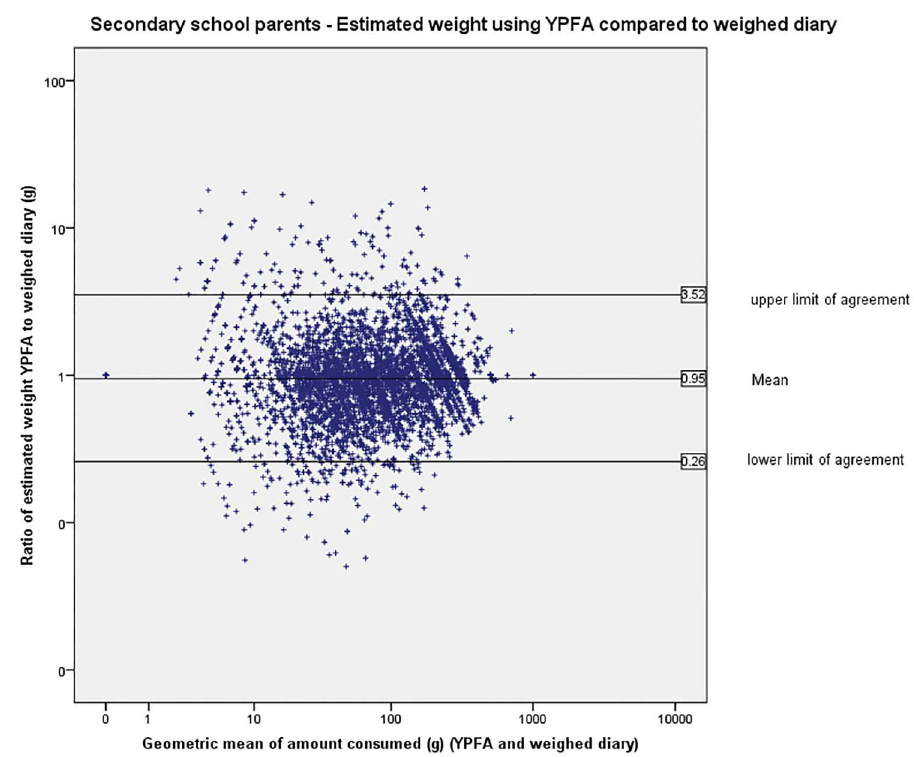
Fig 7. Secondary school parents—Bland-Altman plot showing estimated weight using YPFA compared to weighed diary.